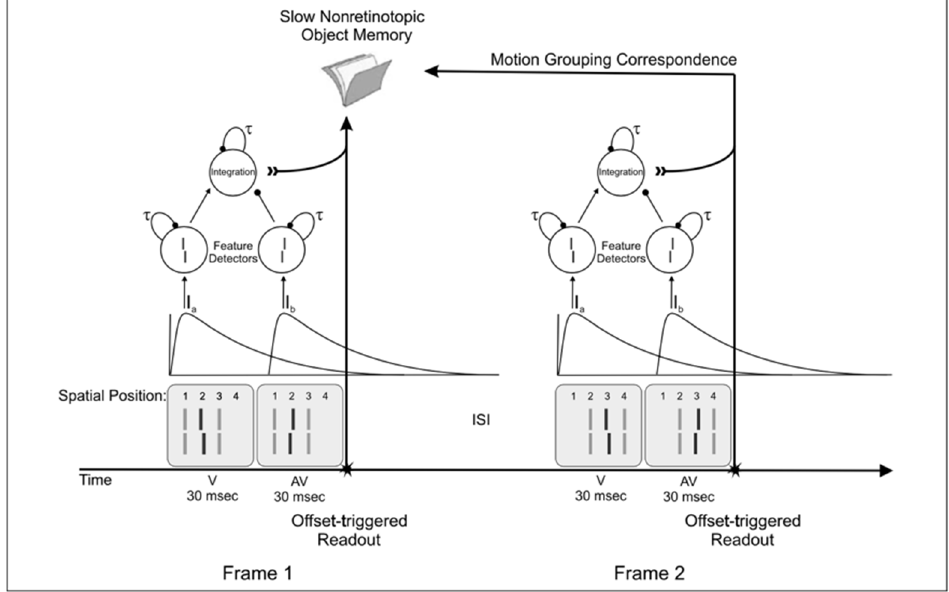
Figure 10. A model for a non-retinotopic object memory and integration. For each frame and retinotopic location, there is an integration neuron, which gives more weight to the second offset. When the first frame disappears, the integration is terminated, and the content stored in memory. It is reopened when the second frame is terminated. Integration occurs according to object correspondence, i.e., non-retinotopically. From Ref. [12].